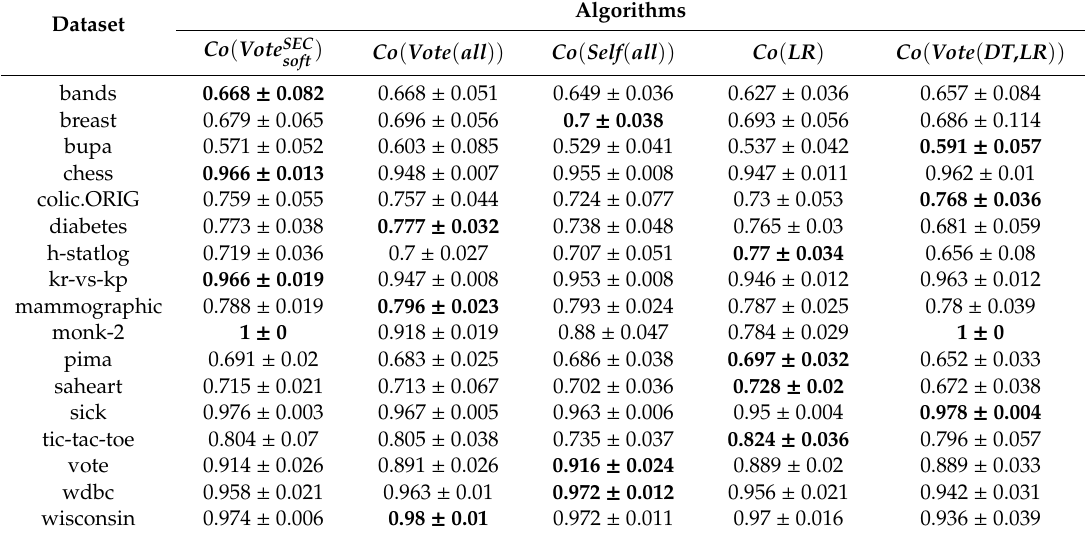
Bold highlighted means the best value per